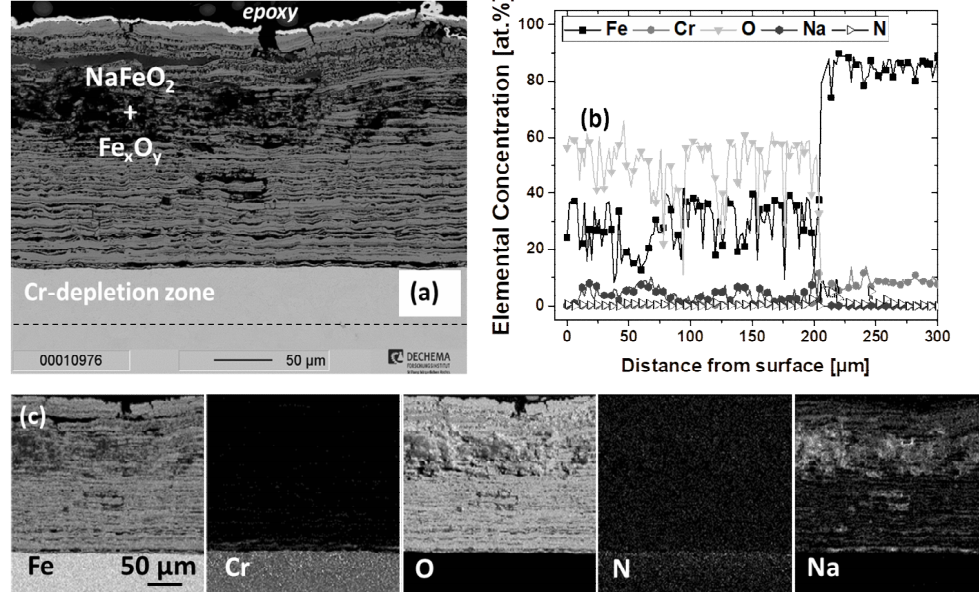
Figure 7. ( a ) Cross-sectional BSE-image, ( b ) quantitative line scans of Fe, Cr, O, Na, and N, and 7 ( c ) elemental distribution maps of uncoated P91 after 1000 h isothermal exposure in molten solar salt at 600 ◦